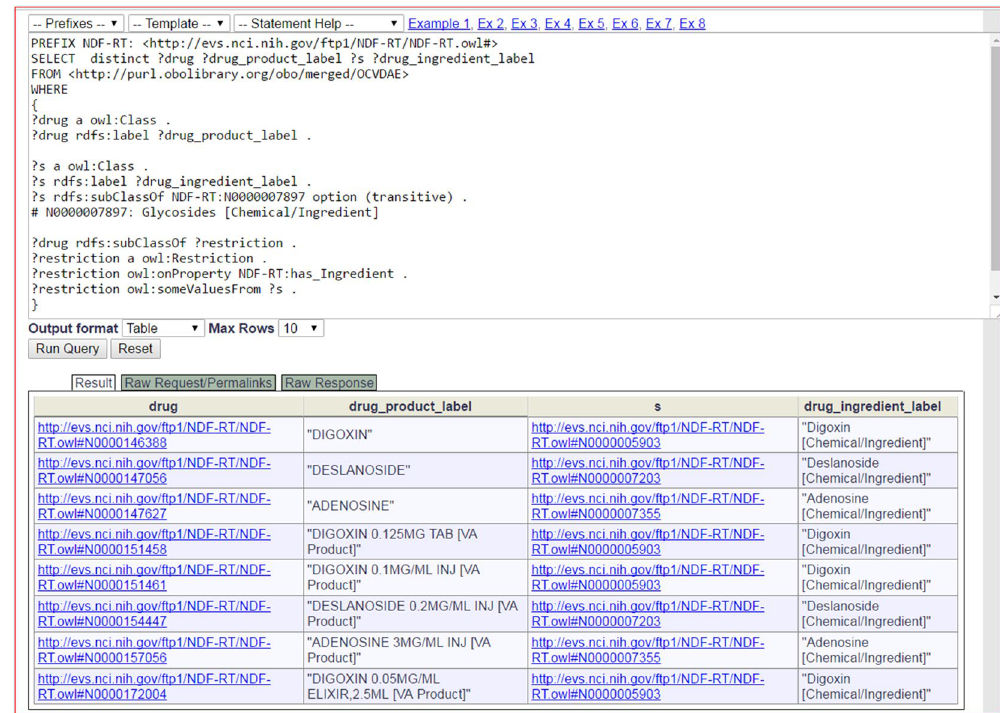
Figure 4. OCVDAE SPARQL script query example. The Ontobee SPARQL server 53 was used to perform this query that identified drug-ingredient pairs with the condition of ingredients under the branch of NDF-RT “Glycosides [Chemical/Ingredient]” (N0000007897). This query returned 8 results, all related to digoxin, deslanoside, and